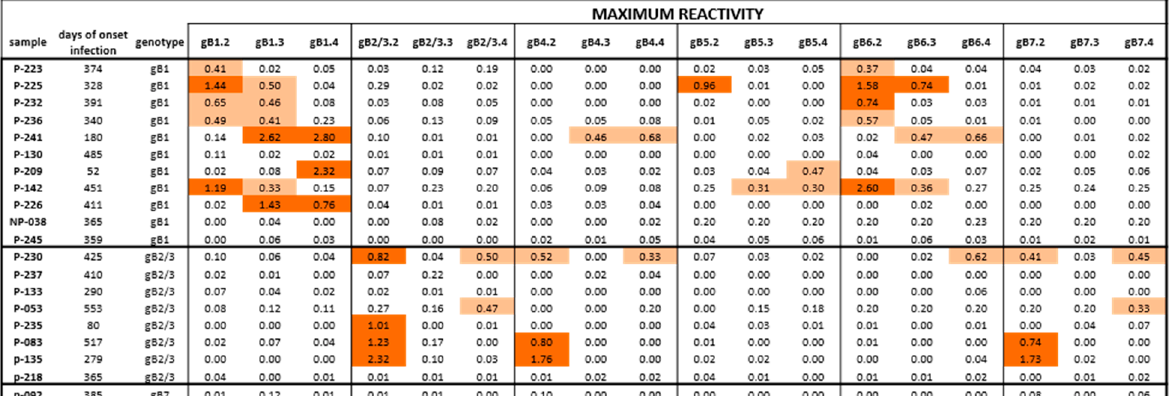
Figure 5. Genotype-specific IgG antibody (OD value) to peptides of the two gH genotypes 1 year after primary HCMV infection. ( A ) IgG response in subjects infected by gH1-HCMV. ( B ) IgG response in subjects infected by gH2-HCMV.